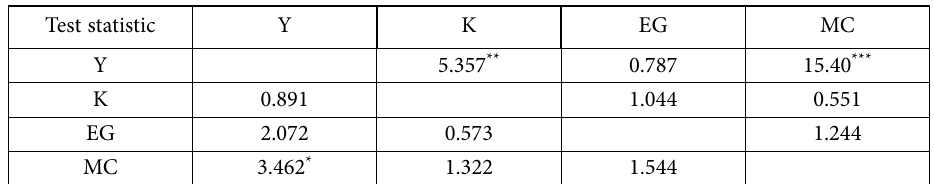
Table 9. The results of the pairwise Granger causality tests (source: authors’ own processing) Test statistic